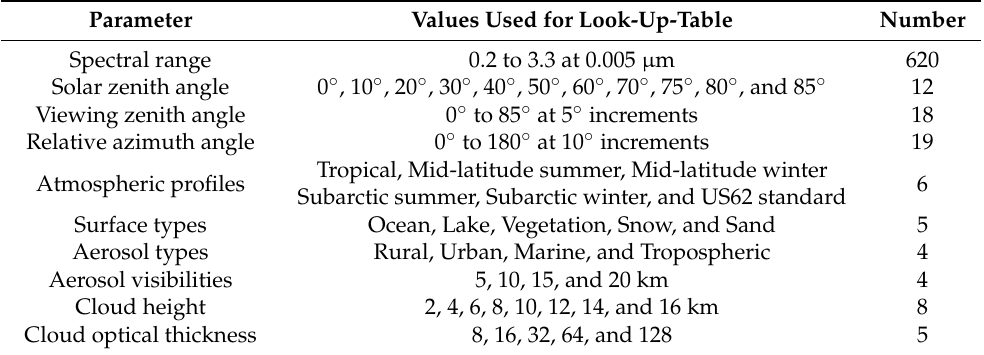
Table 2. Numerical experiments of SBDART for creating regression coefficient look-up-table (LUT).